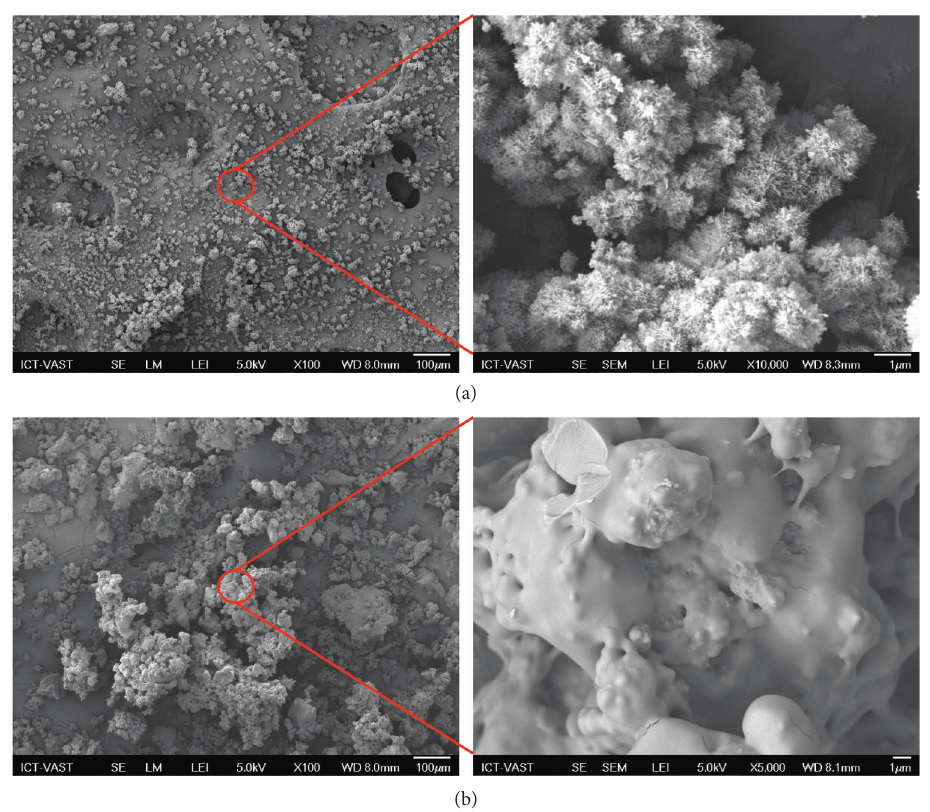
Figure 2: SEM images of (a) ferric oxide and (b) ferric oxide-amine.